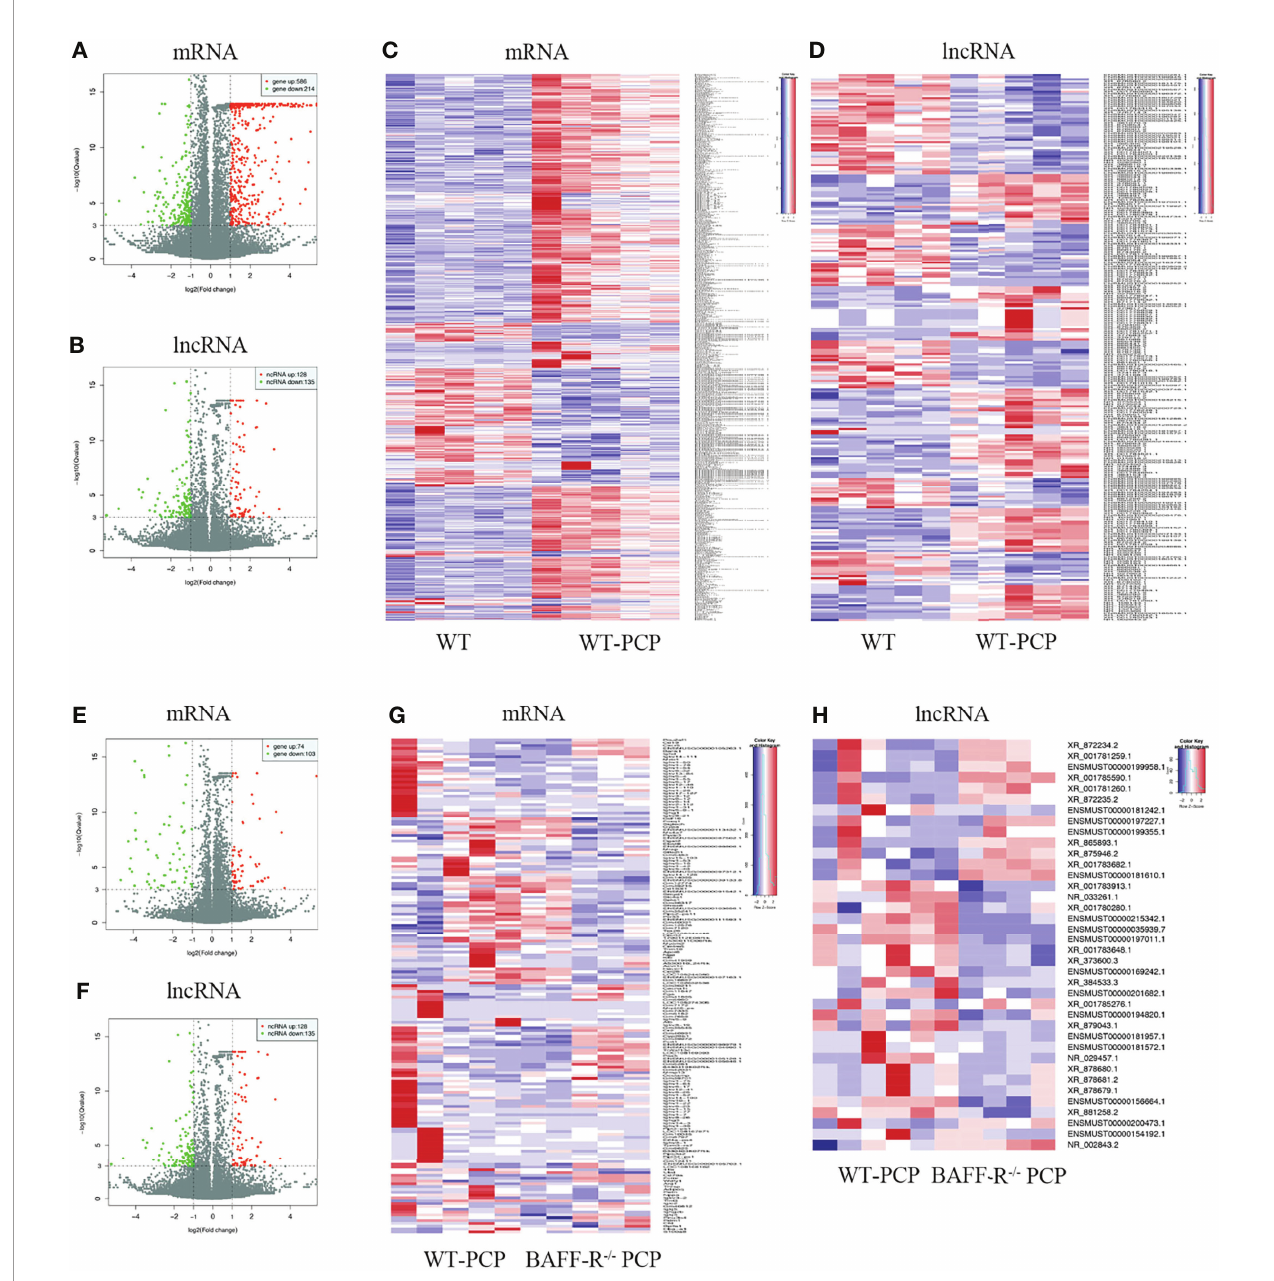
FIGURE 1 | Analysis of differentially expressed genes (DEGs) in the uninfected mice and WT-PCP mice. Volcano plots indicate the respective upregulated and downregulated mRNAs (A) and lncRNAs (B) in mice from the WT-PCP group compared with those from the control group. A heat map shows the differentially expressed mRNAs (C) and lncRNAs (D) between the control group and the WT-PCP group. In the clustering analysis, upregulated and downregulated genes are colored in red and purple, respectively. Analysis of DEGs in WT Pneumocystis infected mice and BAFF-R – / – Pneumocystis infected mice. Volcano plots indicate the respective upregulated and downregulated mRNAs (E) and lncRNAs (F) in mice from the BAFF-R – / – PCP group compared with those from the WT-PCP mice. Heat map shows the differentially expressed mRNAs (G) and lncRNAs (H) between the WT PCP group and BAFF-R – / – PCP mice. In the clustering analysis, upregulated and downregulated genes are colored in red and purple,